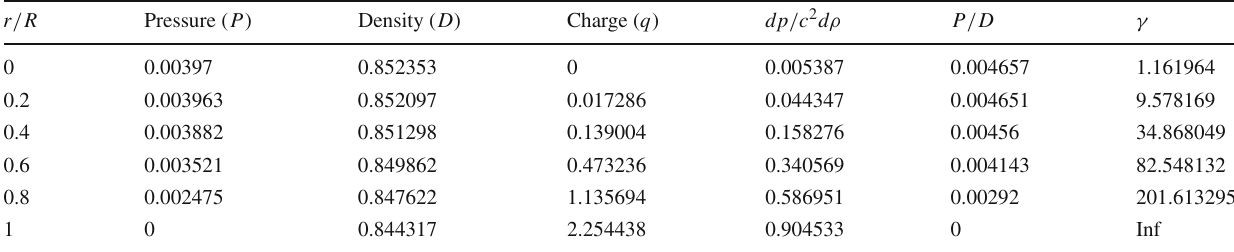
Table 3 Values of the model parameters K = 0 . 034 , C 1 = − 0 . 01 , β 2 = 0 . 835 , b = 0 . 09 , z o = 0 . 284819 , z s = 0 .